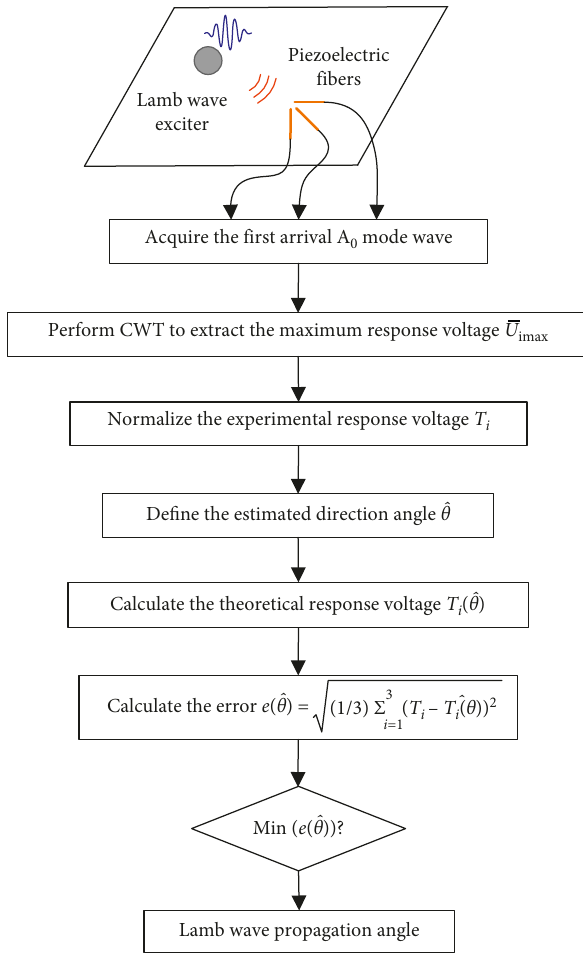
Figure 11: Block diagram of the proposed